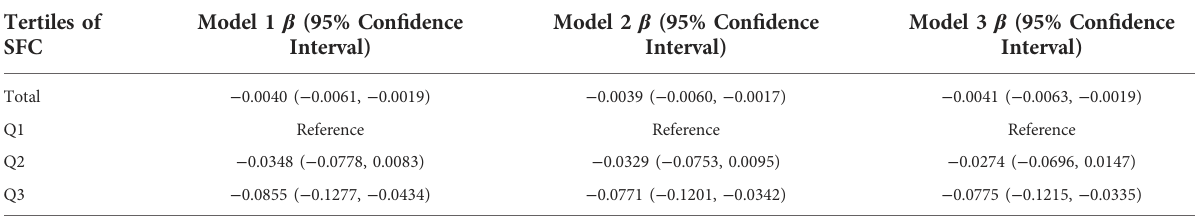
TABLE 2 Regression coef fi cient (95% con fi dence interval) for BLL by serum SFC in adolescents aged 12 – 19 years in the 2007 – 2018 NHANES survey ( n =5,195). Tertiles